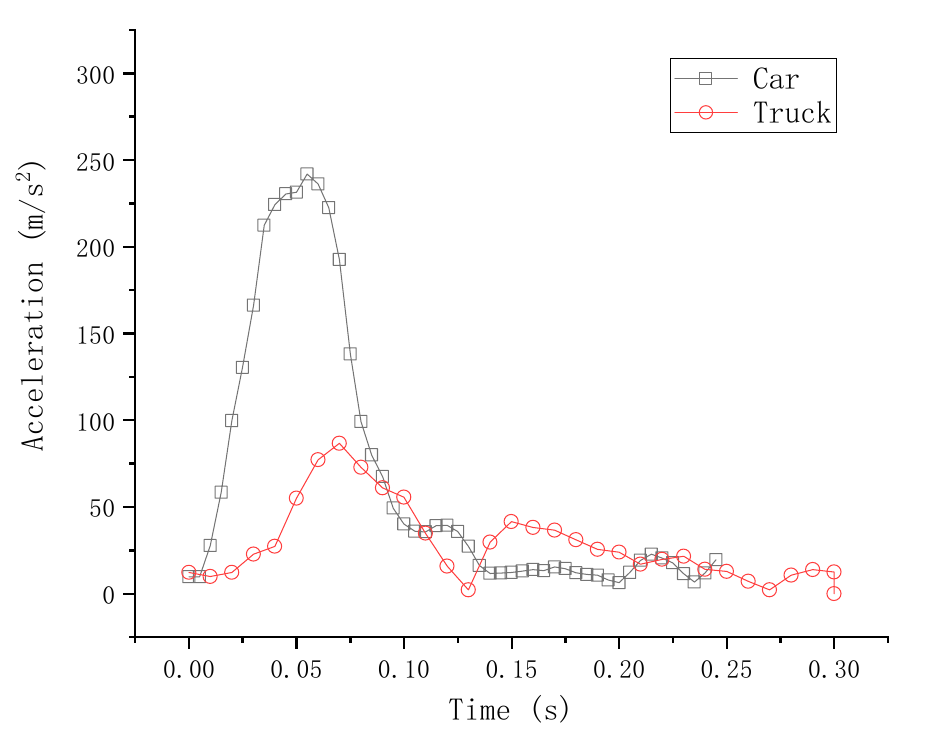
Figure 15. Acceleration–time curve of cars and trucks.